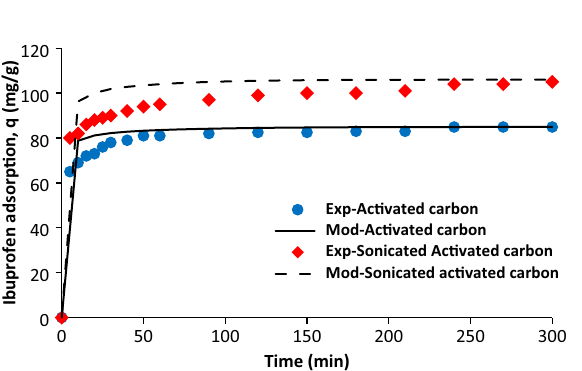
Figure 1. Comparison of experimental data 30 with modelling values, initial ibuprofen concentration = 100 mg/L, T = 298 K, pH = 2, AC porosity = 0.392, SAC porosity = 0.474, adsorbent dosage of 0.5 g/L, and particle radius = 163